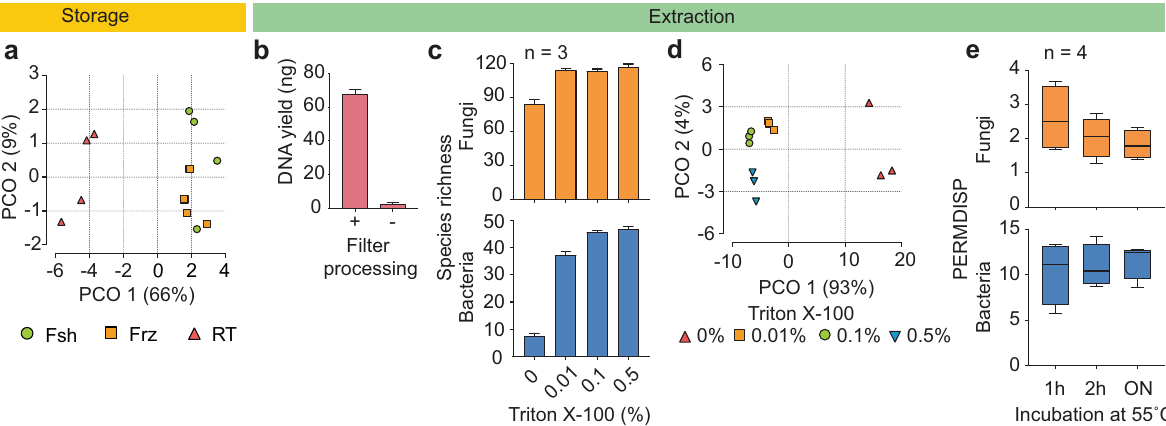
Fig. 4 Storage and biomass extraction. a Principal coordinate analysis (Bray-Curtis) on genus level for samples processed fresh (Fsh), stored in freezer (Frz) and room temperature (RT). b Comparison of DNA yield (ng) with ( + ) and without ( − ) the fi lter wash step. c Total identi fi ed species for fungi (orange) and bacteria (blue) for samples processed with different concentration of detergent (0 – 0.5% v/v) during the wash step. The bars represent mean values and the error bars were standard deviation among the replicates. d Principal coordinate analysis (Bray- Curtis) on genus level for samples processed with different concentration of detergent (0 – 0.5% v/v) during the wash step. e PERMDISP analysis for samples processed with extended incubation at 55 °C prior to cell lysis. The centre line, bound of box and whiskers represent median, 25th – 75th percentile and min-to-max values,